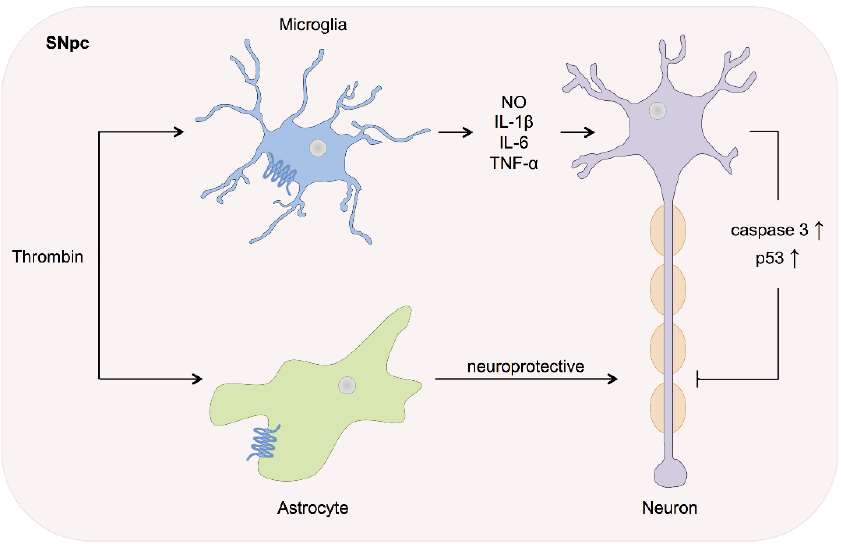
Figure 1. Parkinson’s disease. In PD a progressive loss of dopaminergic neurons and microglia activation in the substantia nigra pars compact (SNpc), is characteristic. Microglia activation by thrombin leads to the expression of NO, IL-1 β , IL-6 and TNF- α, which causes a release of caspase-3 and p53 from the dopaminergic neurons and results in neuronal death. On the other hand, PAR-1 activation in astrocytes seems to exert a more neuroprotective influence.